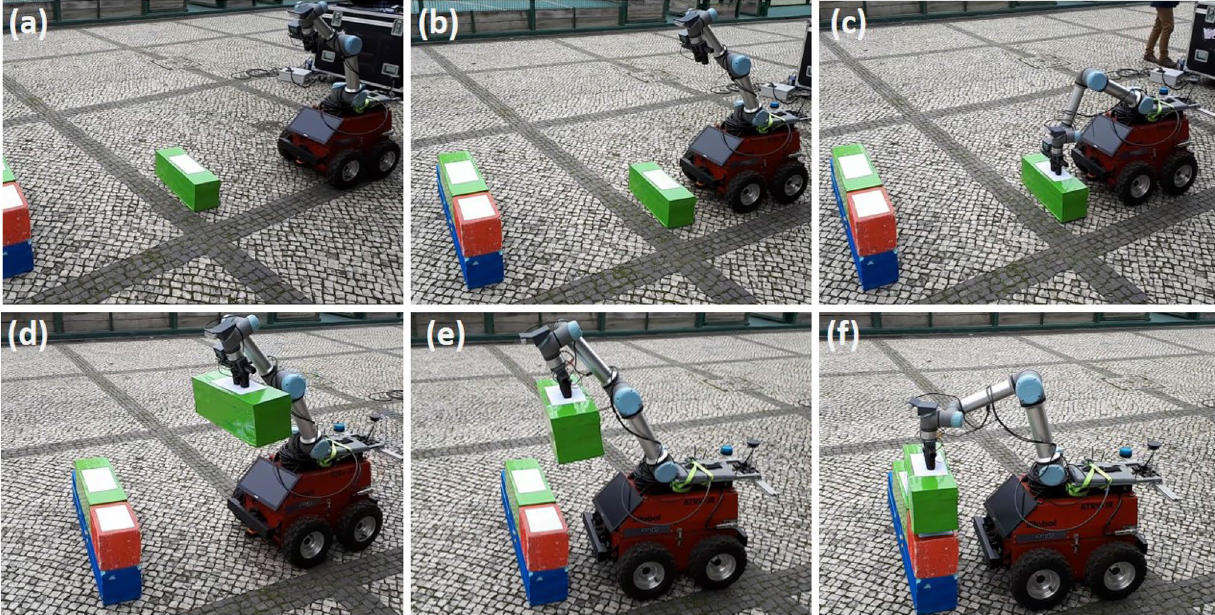
the wall location. e Robot aligns itself with the wall using feedback from the laser scanner and uses the camera at the manipulator to localize the red reference brick on the wall. f The robot places the brick on the third layer while using the edge of the reference brick to calculate the placement